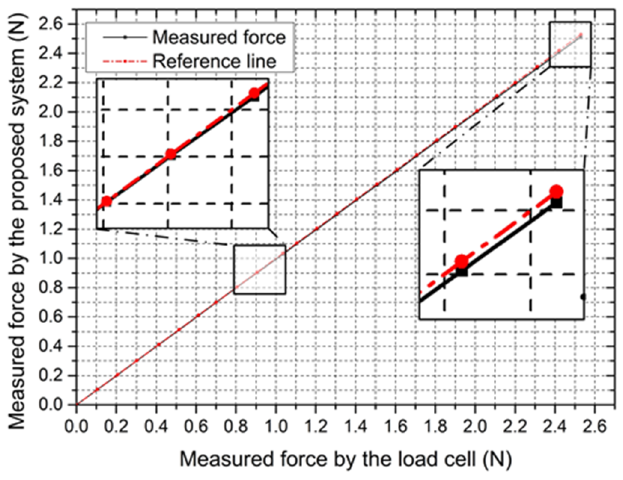
Figure 14. The experimental results for evaluating the static characteristic.